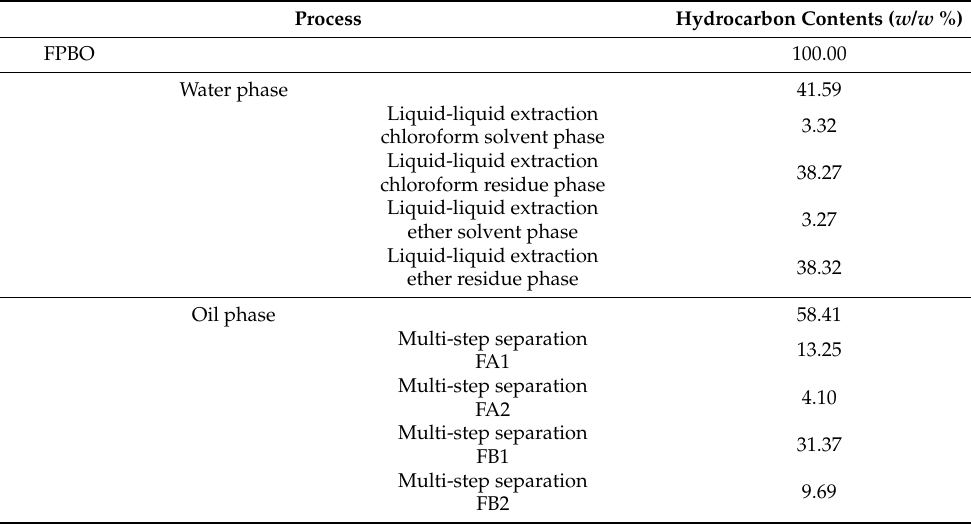
Figure 1. Fractionization and analysis processes of FPBO. Table 1. Fractionization process yields of FPBO.